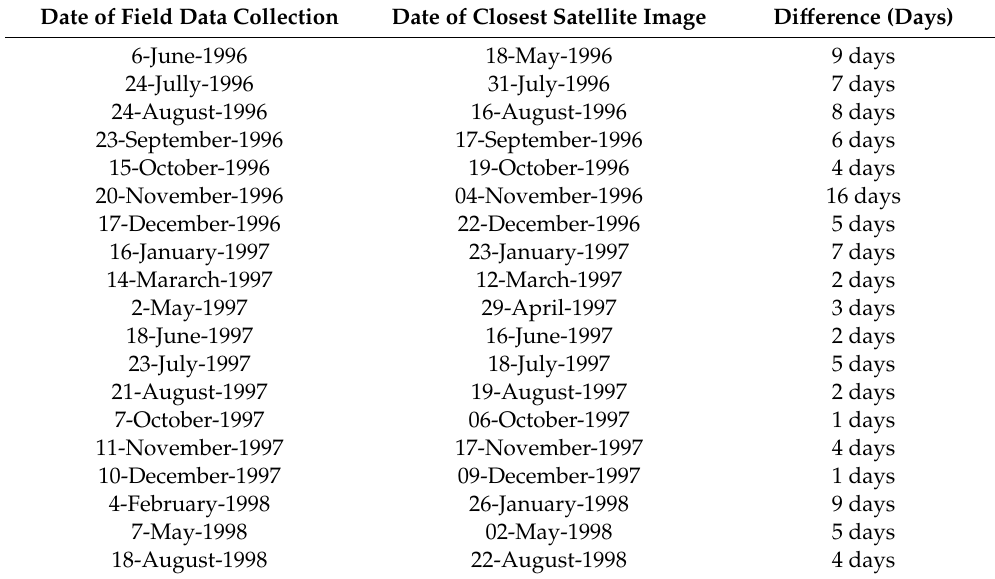
Table 2. Comparison between field data collection dates and satellite image